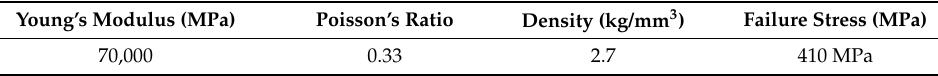
Table 3. Dynamic parameters of 2A12 aluminum alloy.